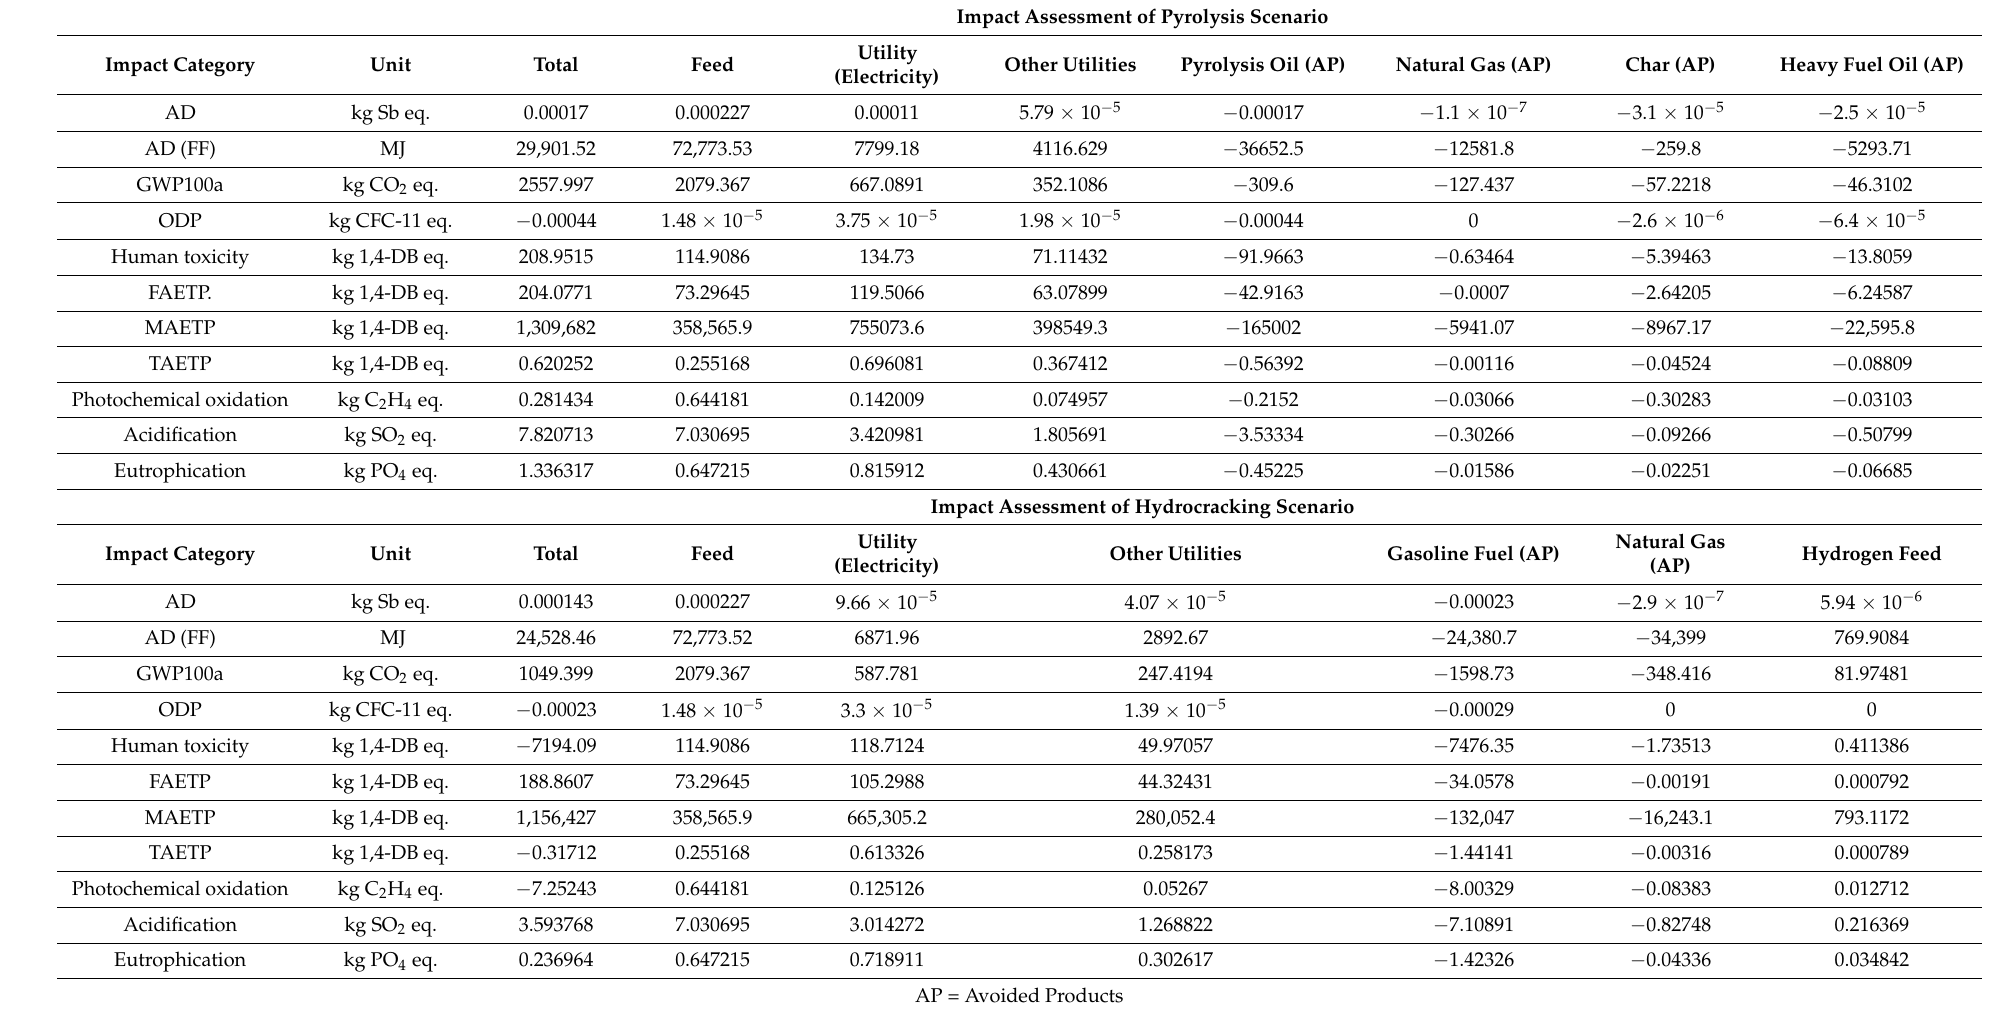
Table 7. Environmental impact due to pyrolysis and